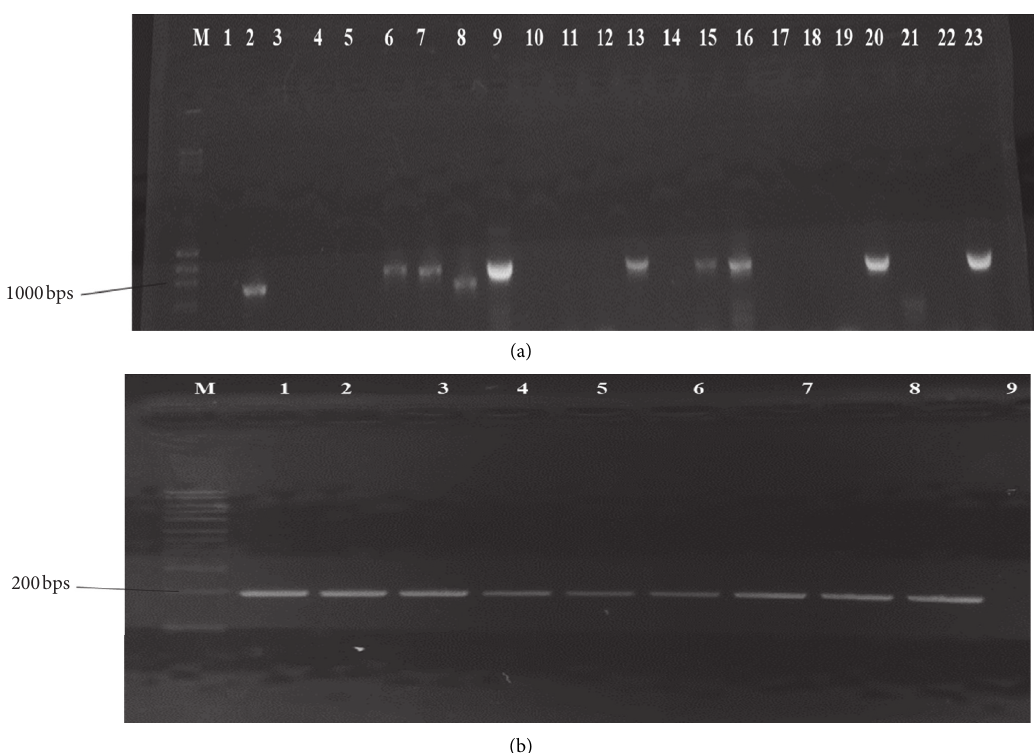
Figure 4: (a) Antibiotic resistance gene Bla TEM detected in bacterial isolates that were resistant to beta-lactam antibiotics. M is the molecular marker; lane 2, isolate KFR222; 6, KF169; 7, KF463, 8, KMP253; 9, KFR285; 13, KF27; 15, KMP188; 16, KF148; 20, KC67; 23, TS572. The band size is in base pairs. (b) Antibiotic resistance gene Dfr A detected in isolates that were resistant to trimethoprim. M is the molecular marker; lane 1, isolate KMP95; 2, TFR329; 3, KFR301; 4, KVS330; 5, TS380; 7, TVS81; 8, KF27; 9, KF391; 10, KF391. The band size is in base